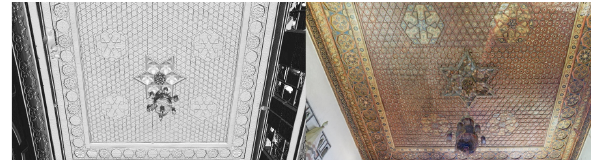
Figure 2: High quality 3D models of Al-‘Azm palace ceiling, produced by DGAM